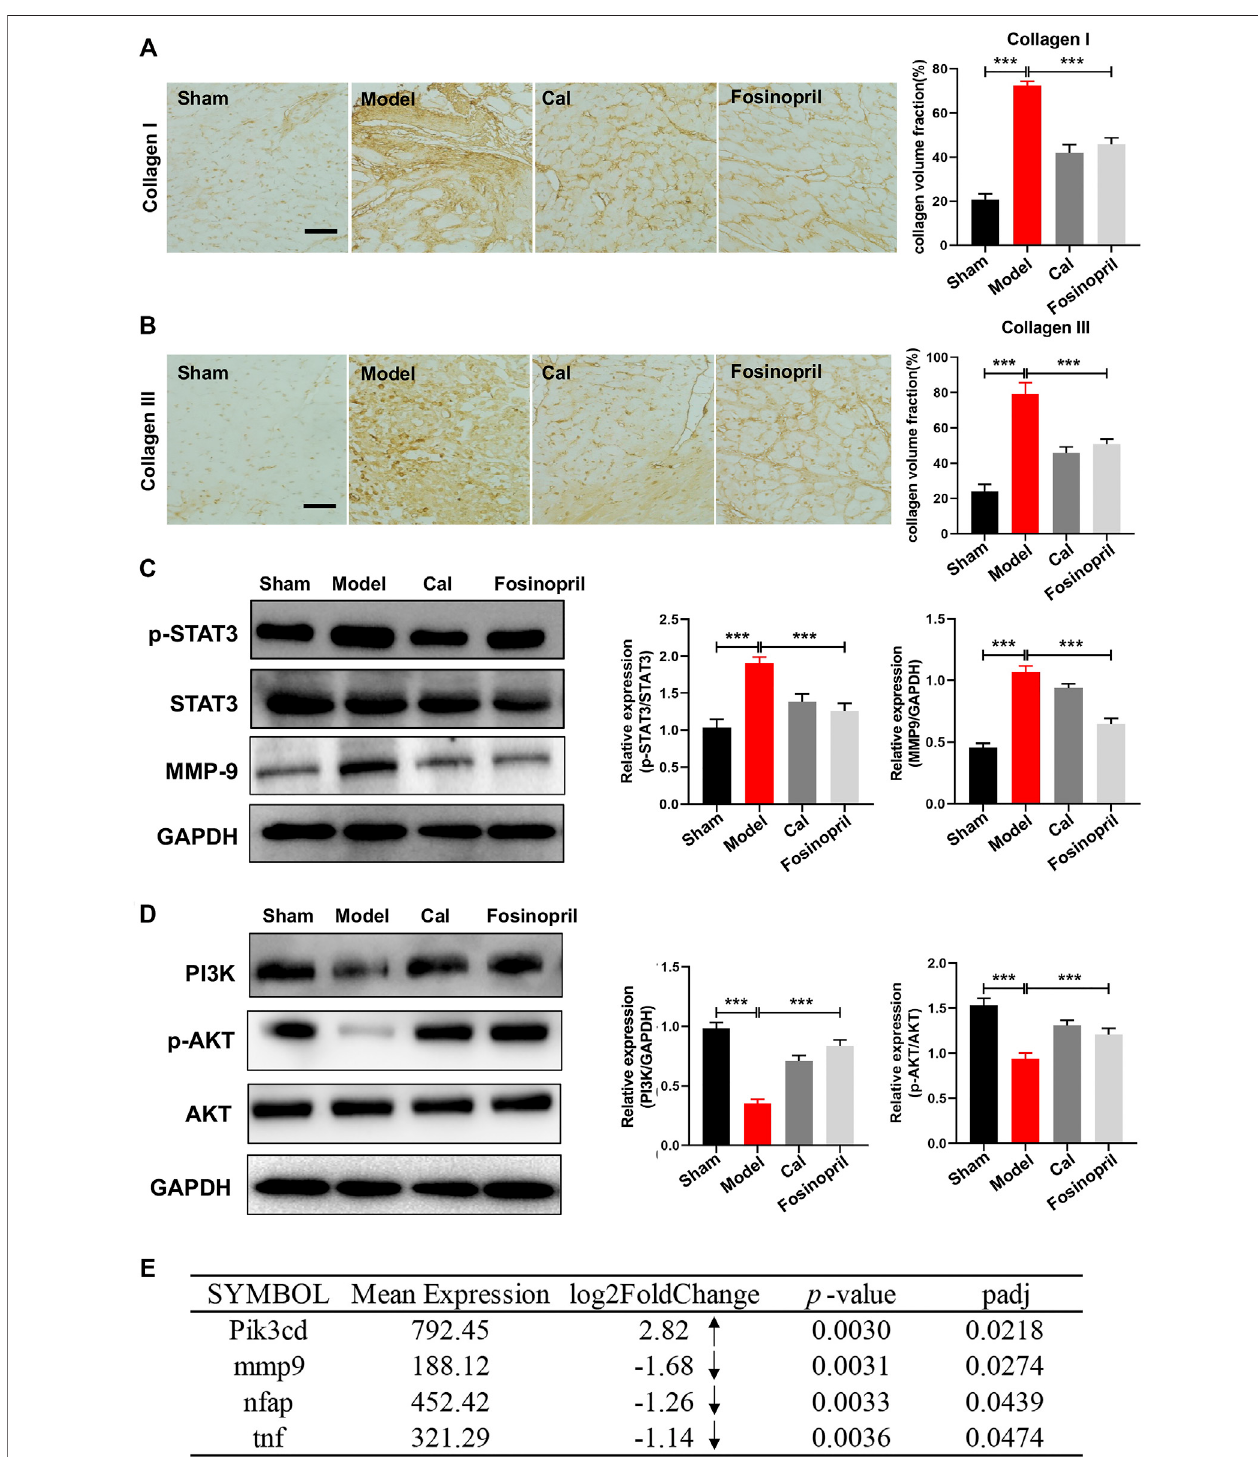
FIGURE4| EffectsofCalonmyocardial fi brosisviatheSTAT3 – MMP9pathway.IHCimagesofcollagen Ⅰ (A) and Ⅲ (B) inHFrats.Quantitativeresultsoftypes Ⅰ and Ⅲ collagen content with IOD value; Cal and fosinopril could signi fi cantly reduce the collagen deposition compared with the model group. (C) Western blot bands of p-STAT3and MMP-9andtheirquantitative resultsinHFrats;Caland fosinoprilcoulddownregulatetheexpressions ofp-STAT3and MMP-9. (D) Westernblotbandsof PI3K, p -AKT, and AKT and their quantitative results in HF rats. (E) The differentially expressed genes between the Cal group and the model group. The arrows representtheupregulated ordownregulatedexpression ofgene.Dataarepresentedasthemean ± standarderrorofthreeindependentexperiments. ( N = 3pergroup, ** p < 0.01, *** p < 0.001).